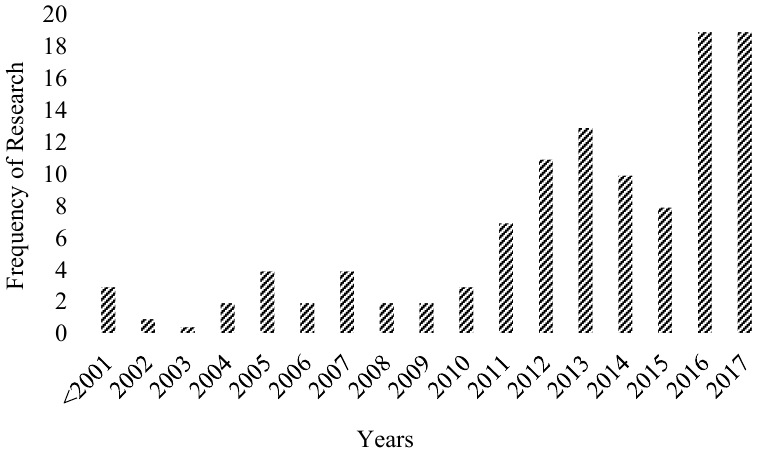
Figure 7. Research trend of GPC modified from [9]; Elsevier, 2018.